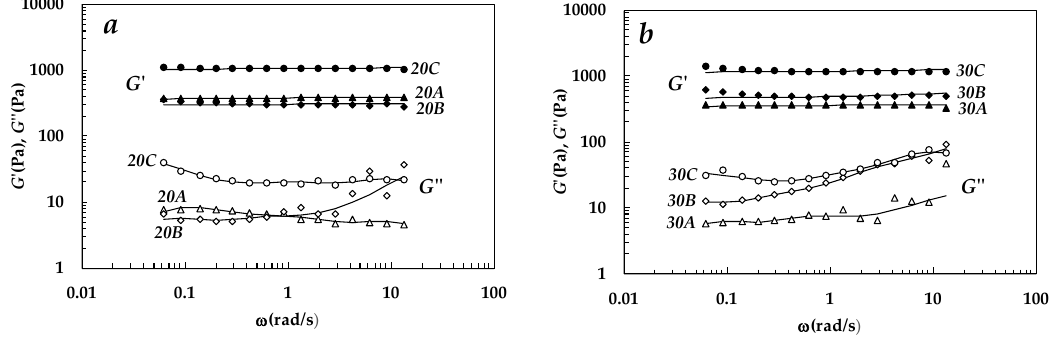
Figure 1. ( a ) Mechanical spectra referring to hydrogels, 20A (polymer mass percentage = 20.5% and 22 min irradiation), 20B (% polymer mass fraction = 20.5% and 33 min irradiation), and 20C (% polymer mass fraction = 20.5% and 44 min irradiation). ( b ) Mechanical spectra referring to hydrogels, 30A (% polymer mass percentage = 30.5% and 22 min irradiation), 30B (% polymer mass percentage = 30.5% and 33 min irradiation), and 30C (% polymer mass percentage = 30.5% and 44 min irradiation). Filled symbols represent the storage modulus, G’, while open symbols indicate the loss modulus, G’’. Solid lines are the best fitting of the generalized Maxwell model (Equations (1)–(2)).